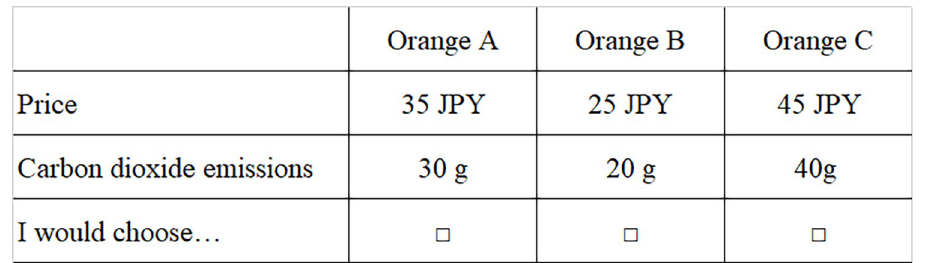
Fig 2. An example of a choice